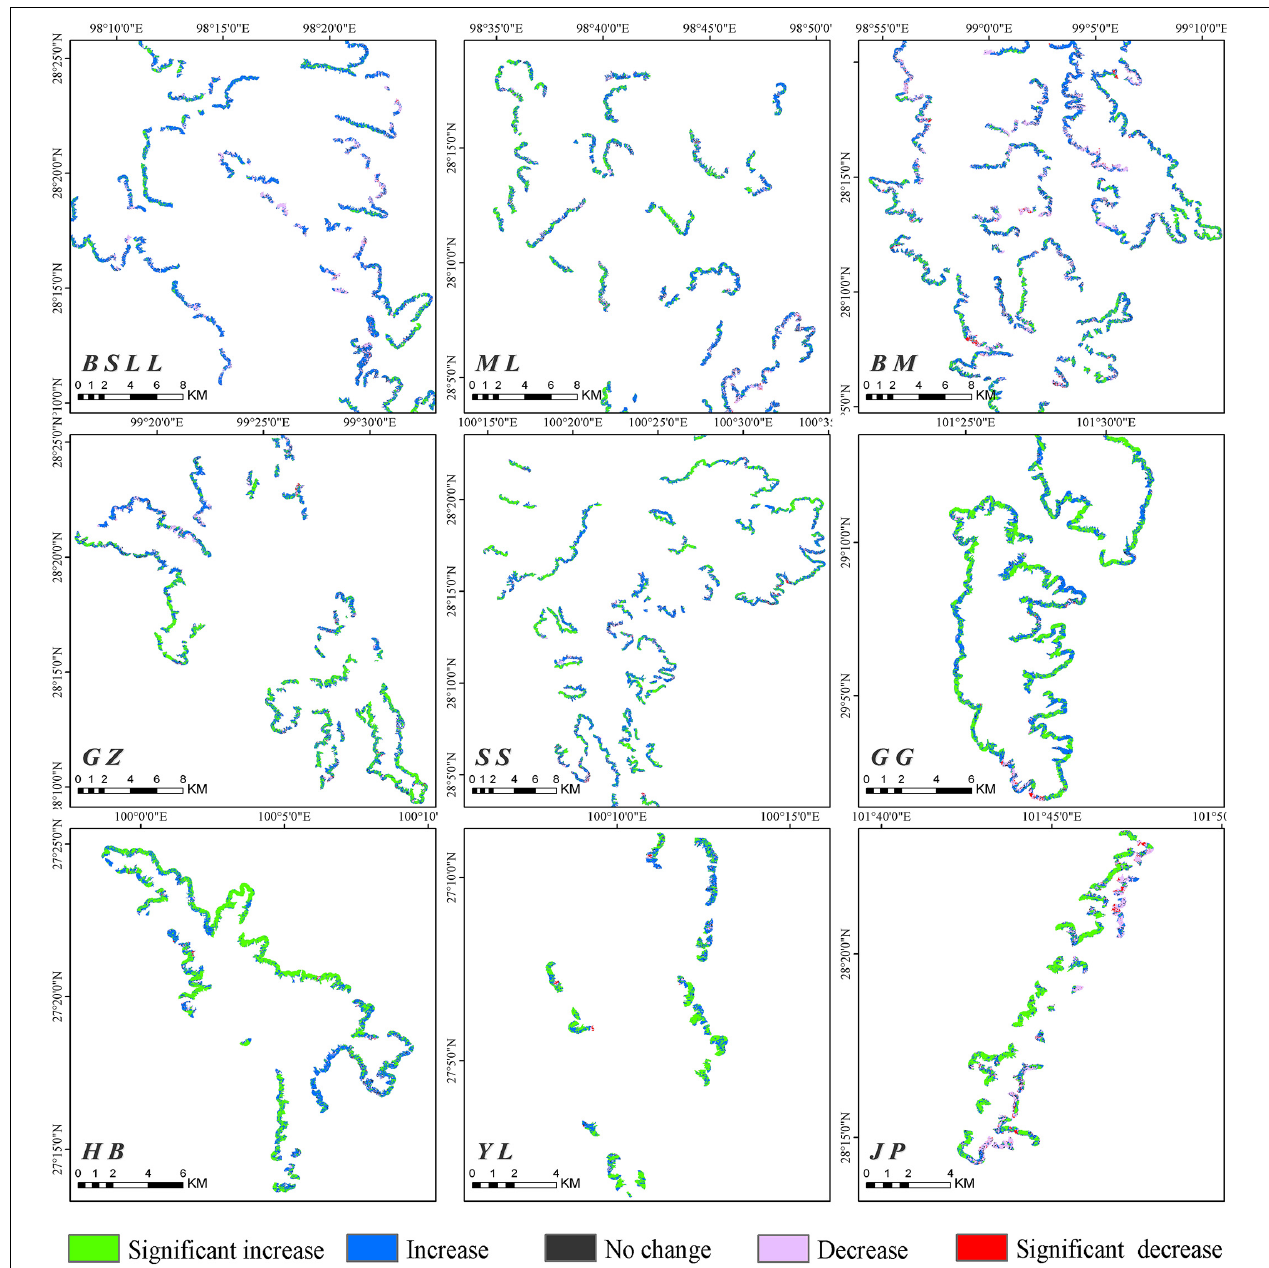
FIGURE 6 | Spatial variation trend analysis of fraction vegetation cover on the main mountains in the Hengduan Mountains from 2000 to